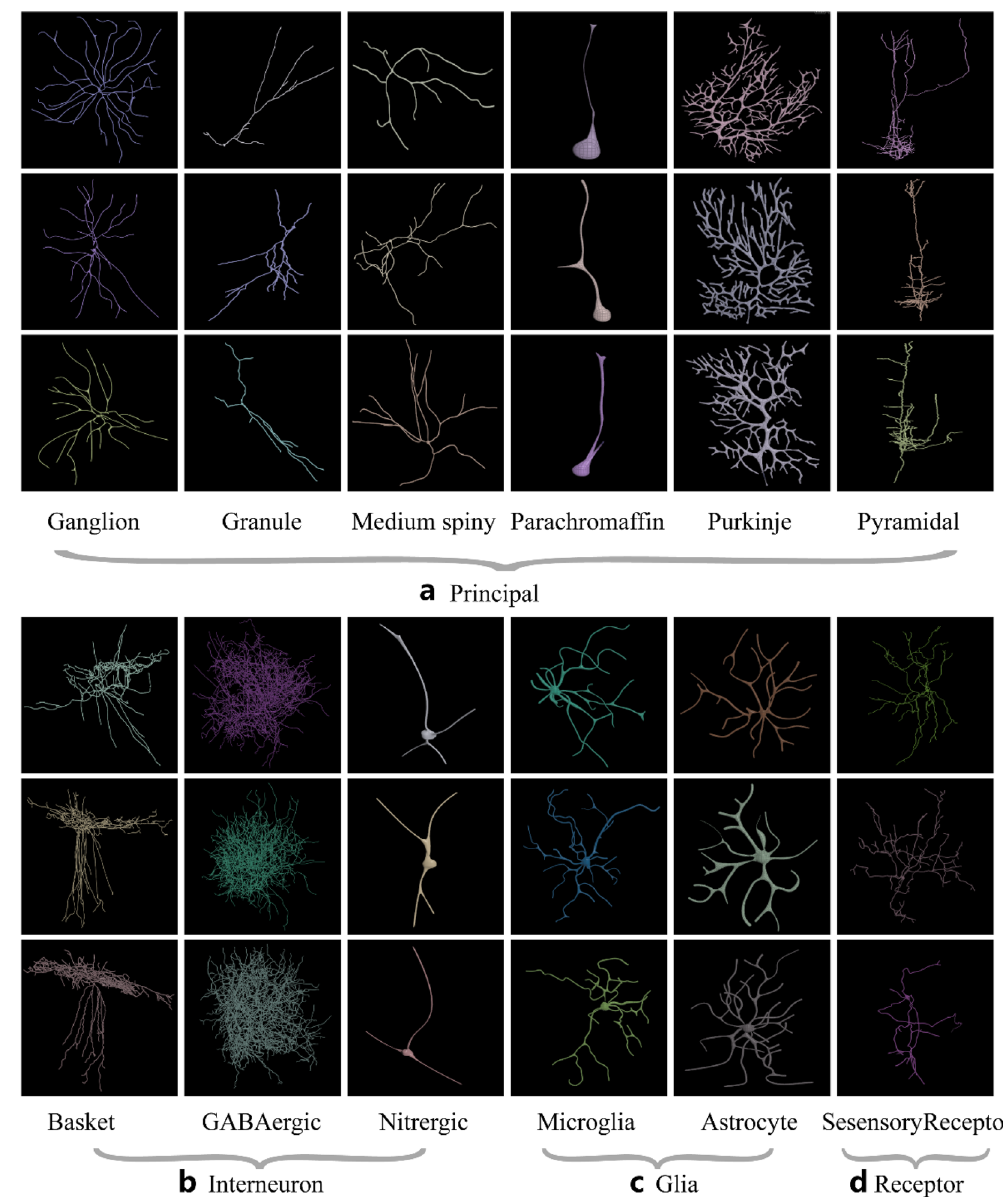
Figure 2. The neuronal morphologies from SWC-format data after repairing with Trees toolbox. The Houdini software generates the 3D model of neurons. Here, we show three examples for each class of neurons in the NeuroMorpho-rat dataset. ( a ) The six types of principal cells: ganglion, granule, medium spiny, parachromaffin, Purkinje, and pyramidal cells. ( b ) The three types of interneuron cells: basket, GABAergic, and nitrergic cells. ( c ) The two types of glial cells: microglia and astrocyte cells. ( d ) The 1 type of sensory receptor